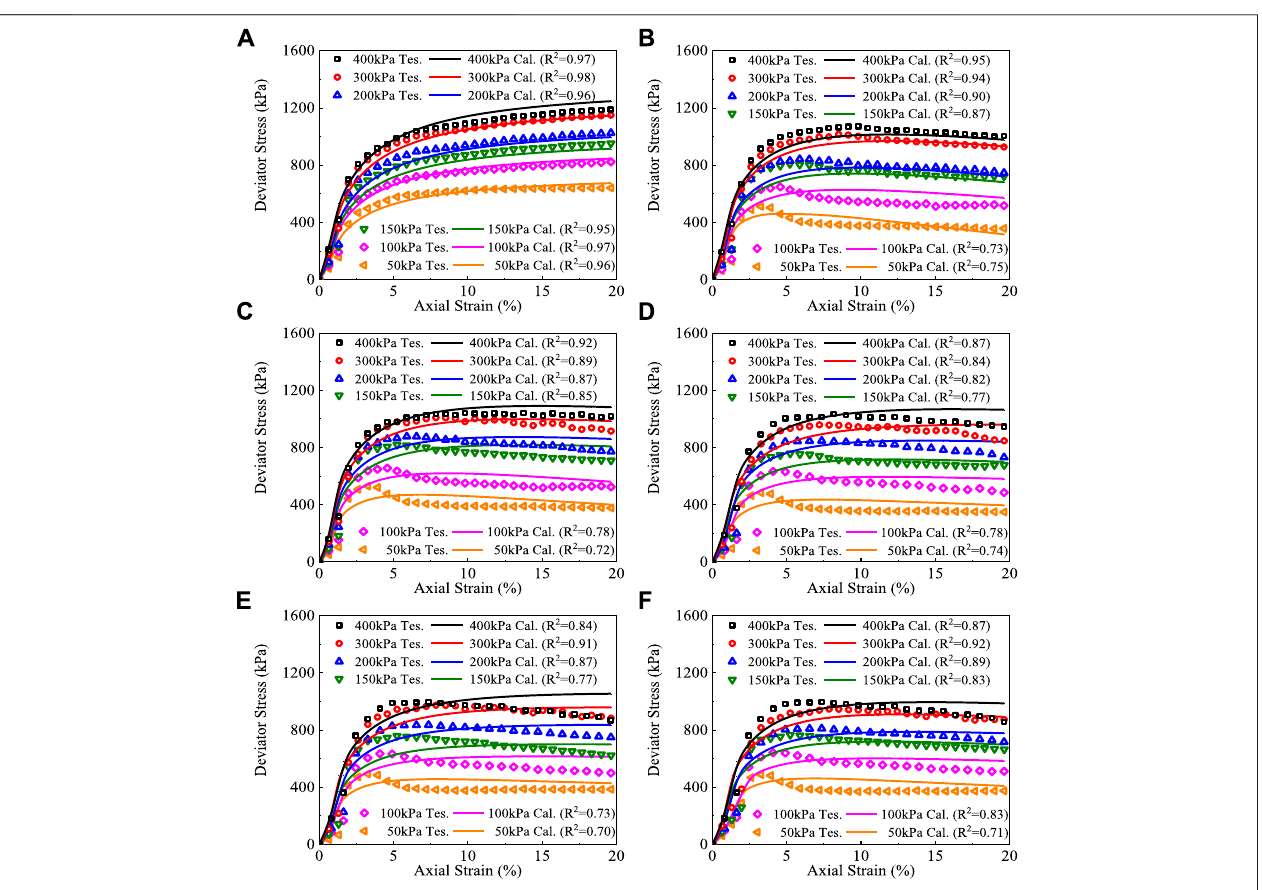
FIGURE 14 | Tested and calculated stress-strain results of tested clay. (A) 0 FT cycle. (B) 1 FT cycle. (C) 3 FT cycles. (D) 6 FT cycles. (E) 10 FT cycles. (F) 15 FT cycles.